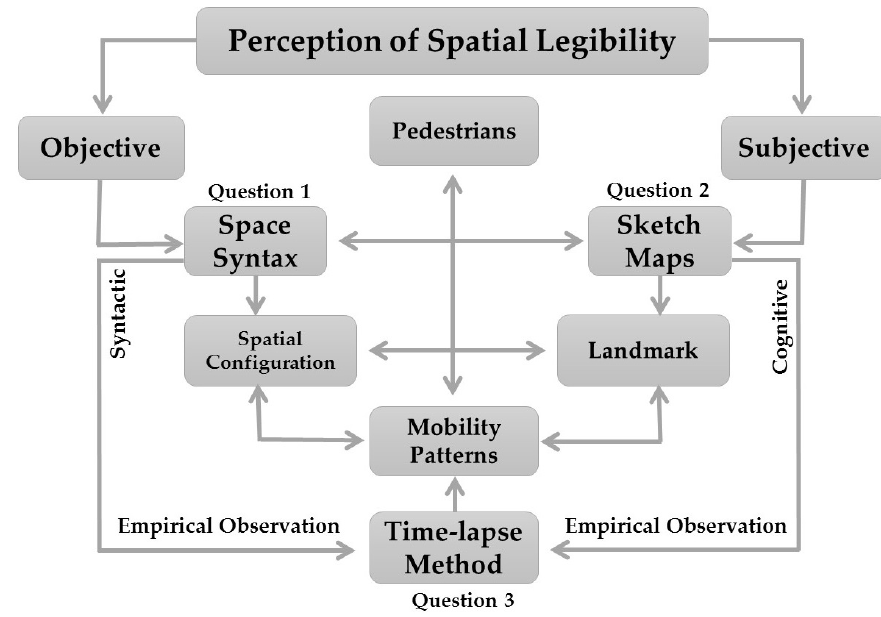
Figure 1. Research design and the functional interrelation of the adopted procedures.